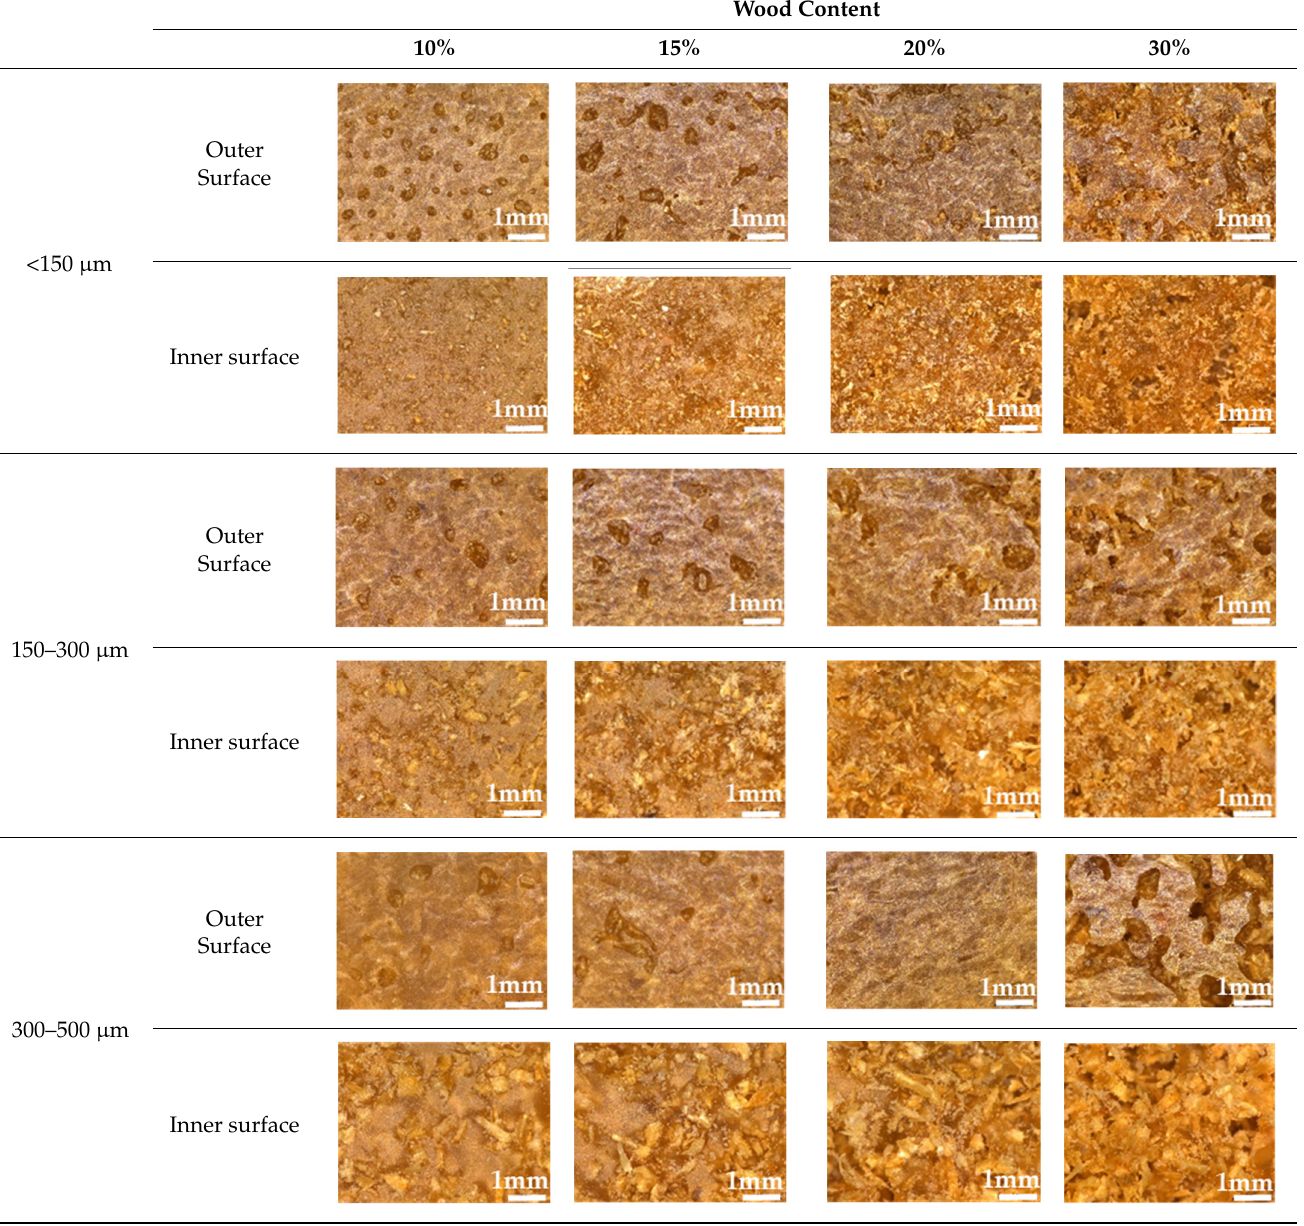
Table 6. Effect of wood granulometry and wood content on the surface characteristics of PE/wood parts.